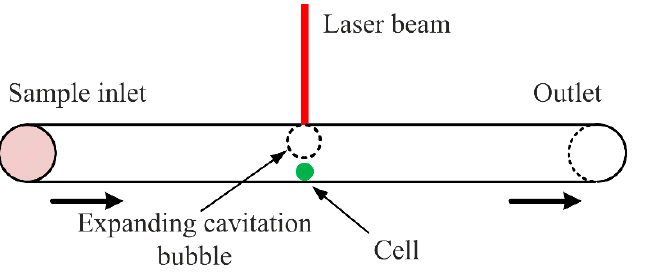
Figure 23. Schematic representation of the working mechanism of the laser lysis in microfluidics.